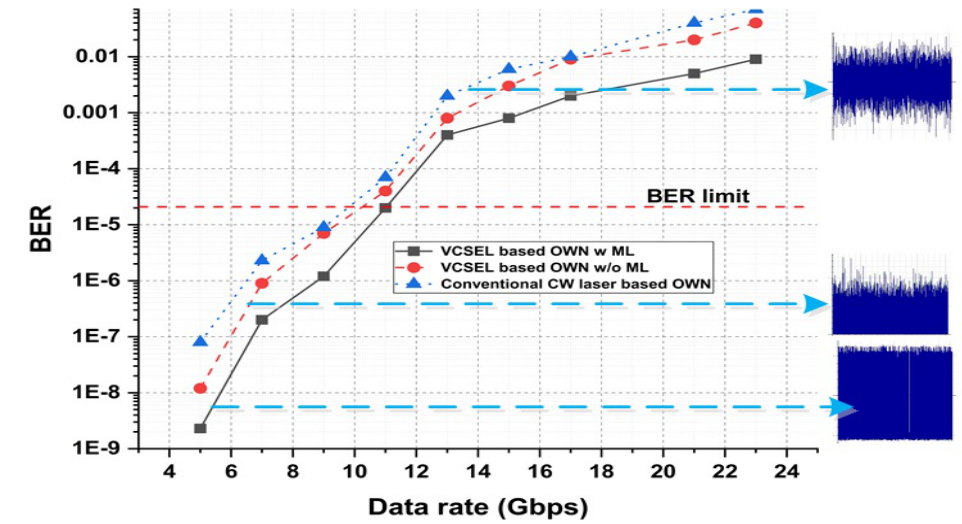
Figure 5. Data rate evaluation as a function of BER using VCSEL-based OWN with ML, conventional laser, and VCSEL-based OWN without